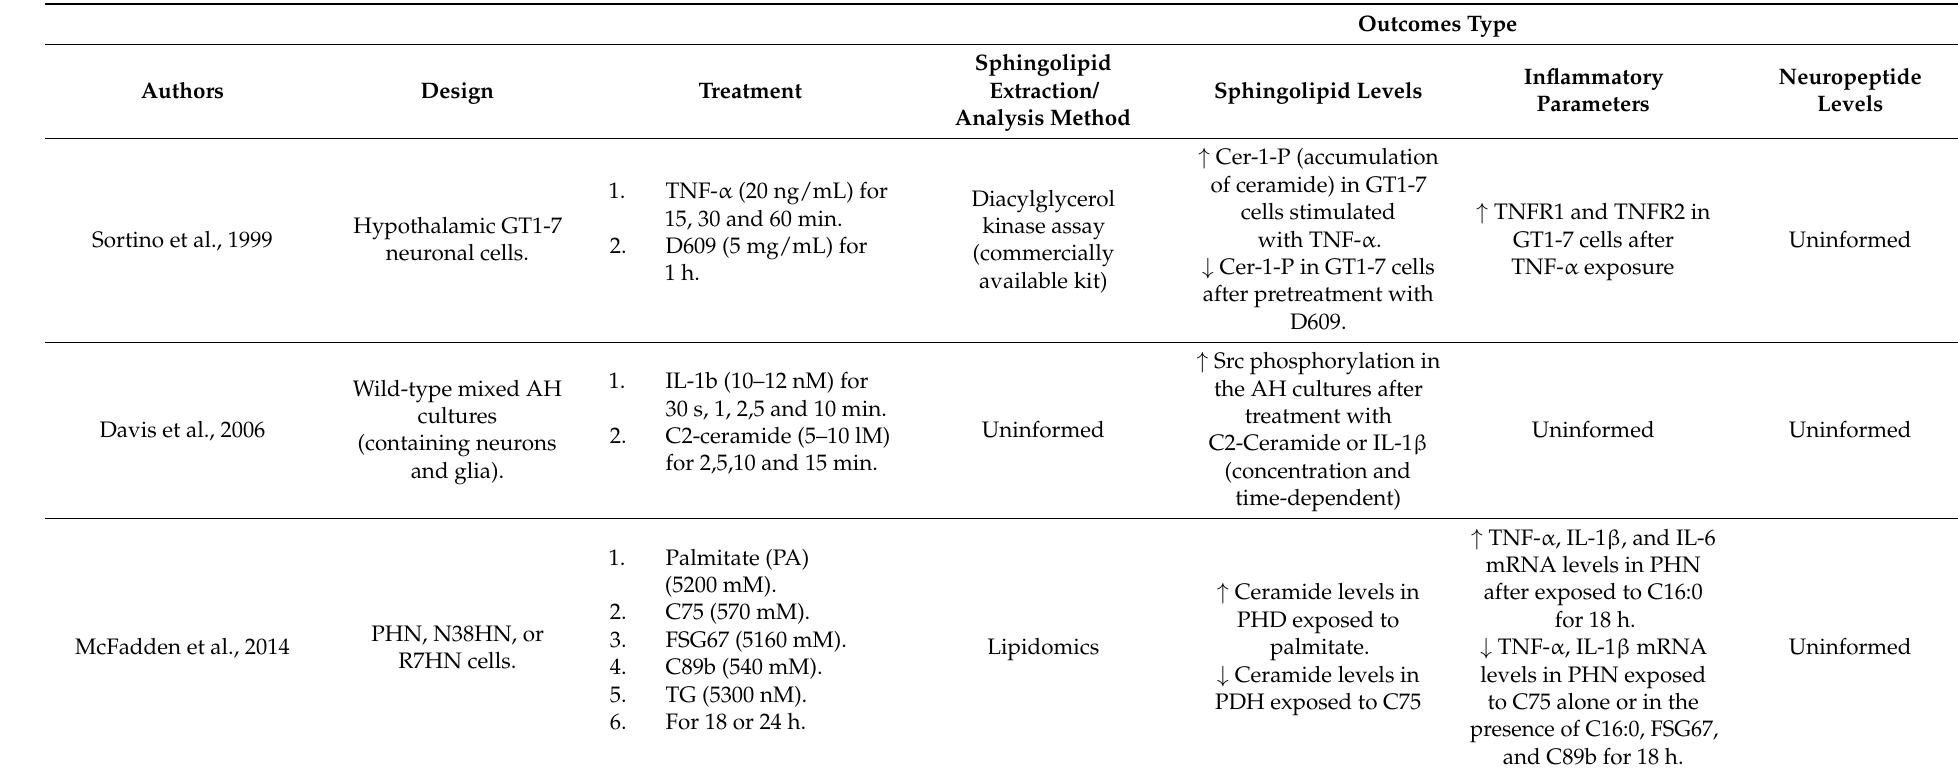
Table 2. Characteristics and analysis of outcomes for in vitro